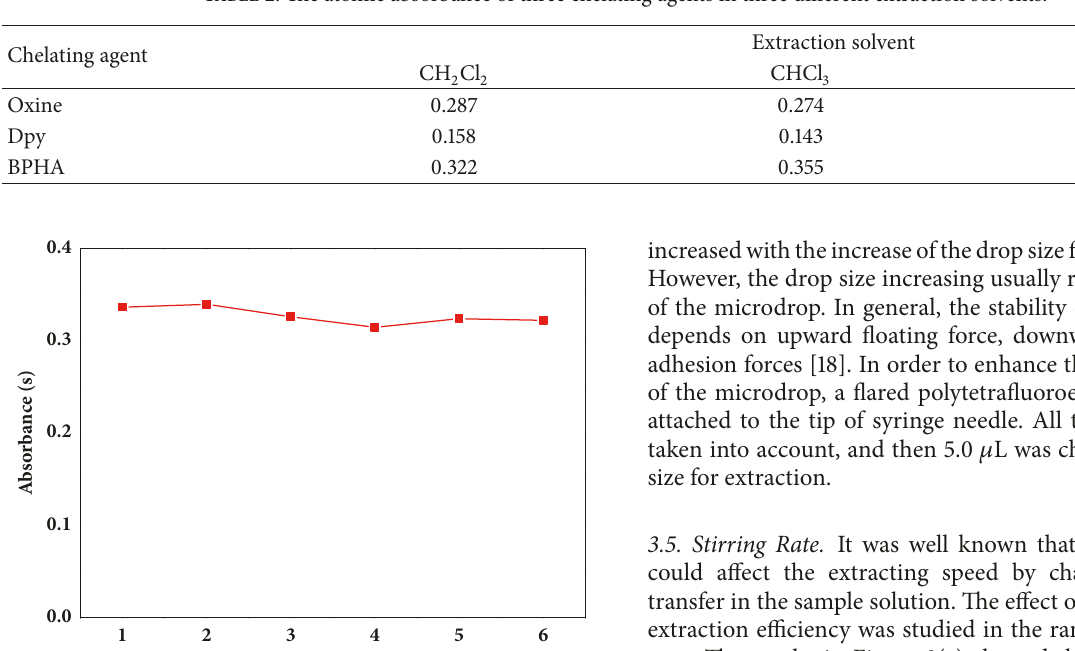
Table 2: The atomic absorbance of three chelating agents in three different extraction solvents.